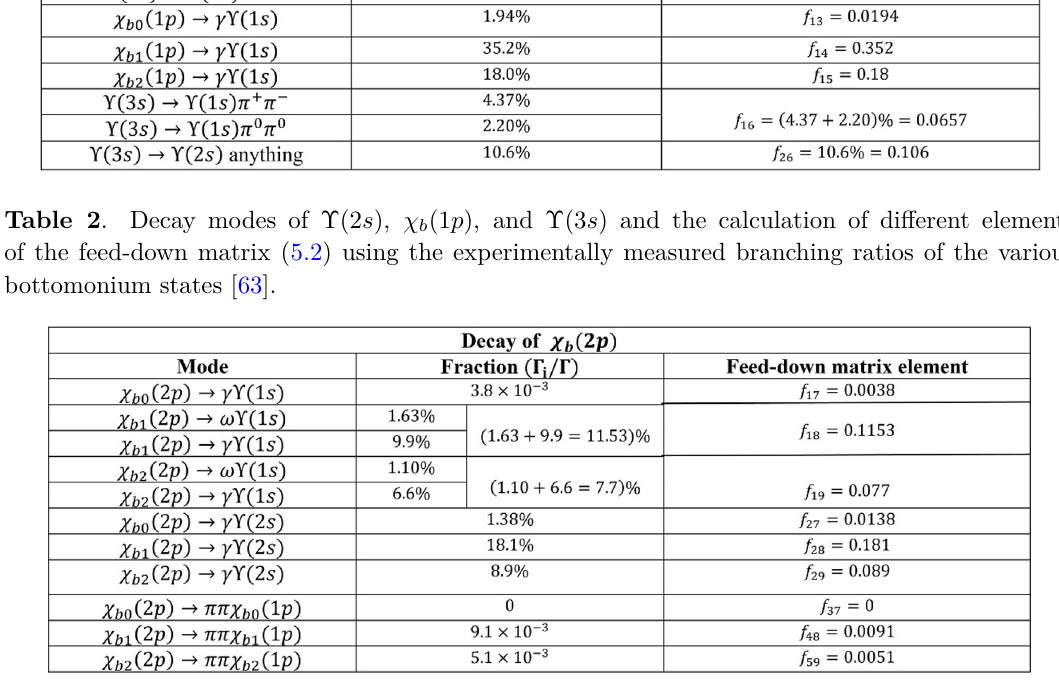
Table 3 . Decay modes of χ b (2 p ) and the calculation of different elements of the feed-down matrix (5.2) using the experimentally measured branching ratios of the various bottomonium states